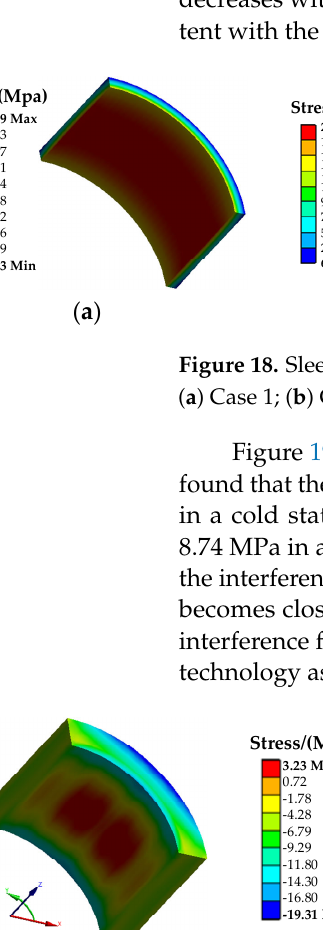
Figure 17. Air ‐ friction losses in the three cases at rated speed. Figure 17. Air-friction losses in the three cases at rated speed.